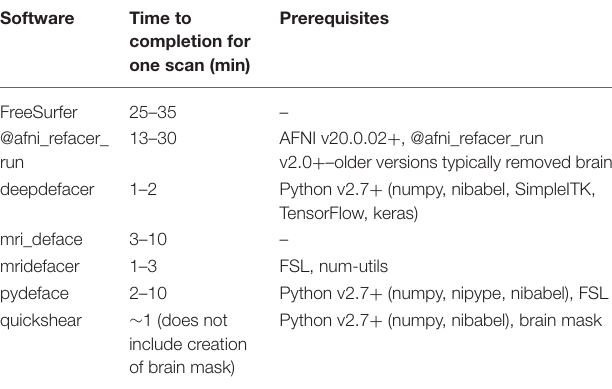
TABLE 6 | Completion time and prerequisites required for each tested algorithm.